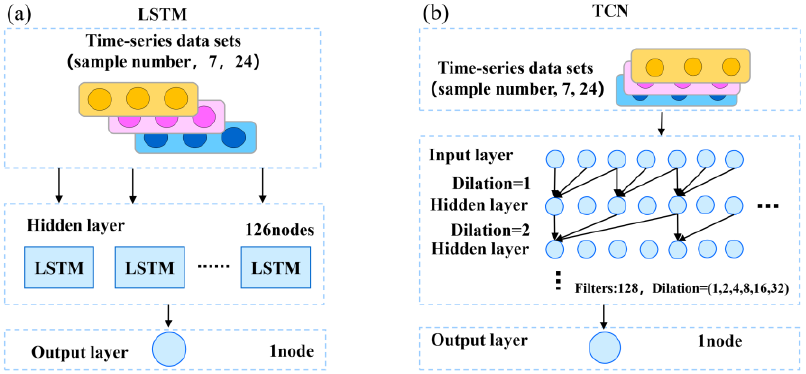
Figure 4. Architectures of the sub-neural network model in an ensemble neural network ( a ) long short-term memory (LSTM) and ( b ) temporal convolutional network